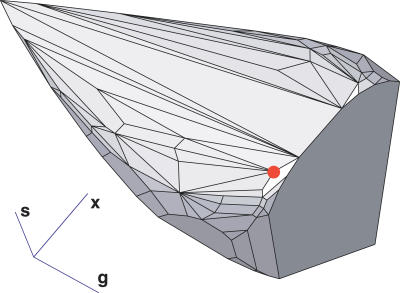
The Third Alignment Polytope of Our Two Drosophila Introns Has 76 VerticesThe marked vertex (x,s,g) = (30,5,2) represents the BLASTZ alignment.